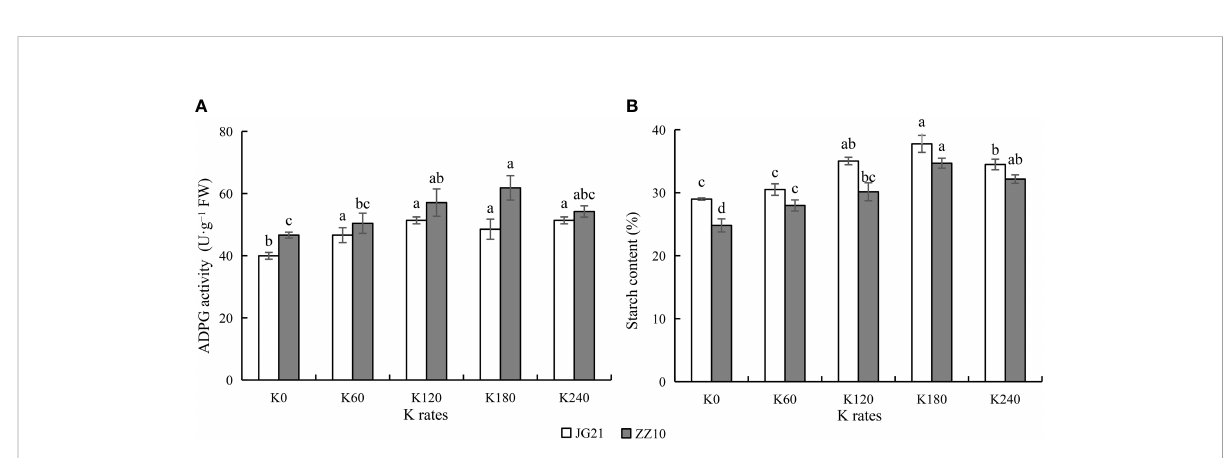
FIGURE 6 Effects of potassium application rate on ADPG activity and starch content of foxtail millet grains at grain fi lling stage (2021). Two cultivars were tested, Jingu 21 (JG21) and Zhangza 10 (ZZ10). Potassium applications include 5 level 0 (K 0 ) as control, 60 (K 60 ), 120 (K 120 ), 180 (K 180 ), and 240 (K 240 ) kg·hm − 2 of K 2 O. The different normal letters indicate signi fi cant differences in different treatments of the same variety at the 0.05 level. Values are means ± SE (n = 3). (A) ADPG, ADPG pyrophosphorylase. (B) starch content.